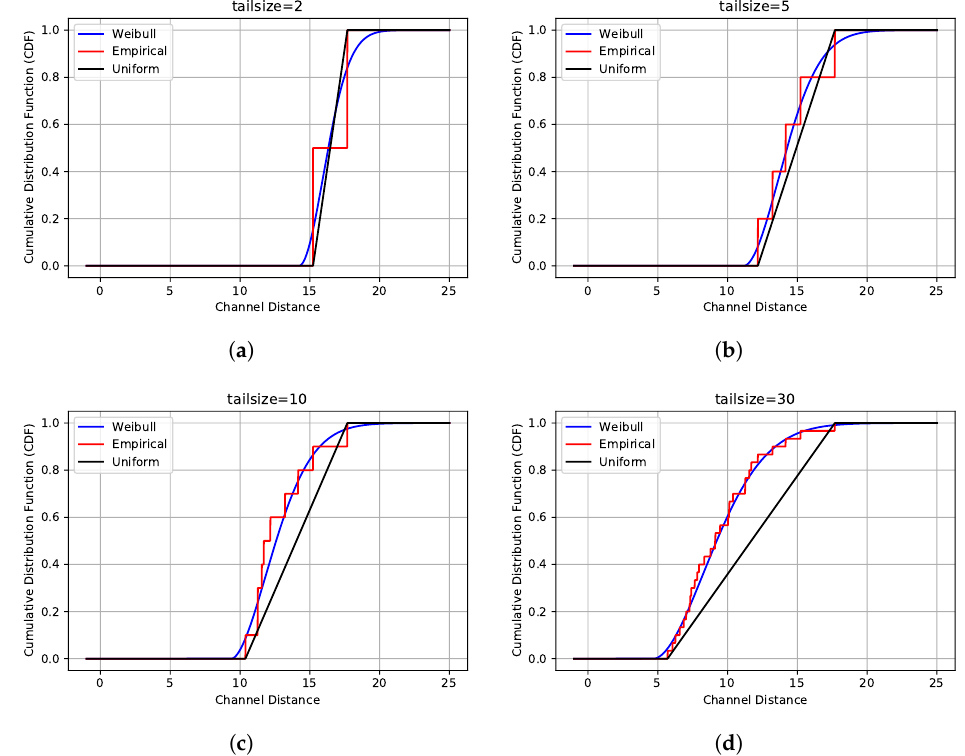
Figure 12. Three different CDFs, i.e., Uniform, Empirical and Weibull distributions, fitted to the tails of distance values of images in class zero ( a ) η = 2, ( b ) η = 5, ( c ) η = 10, ( d ) η = 30.